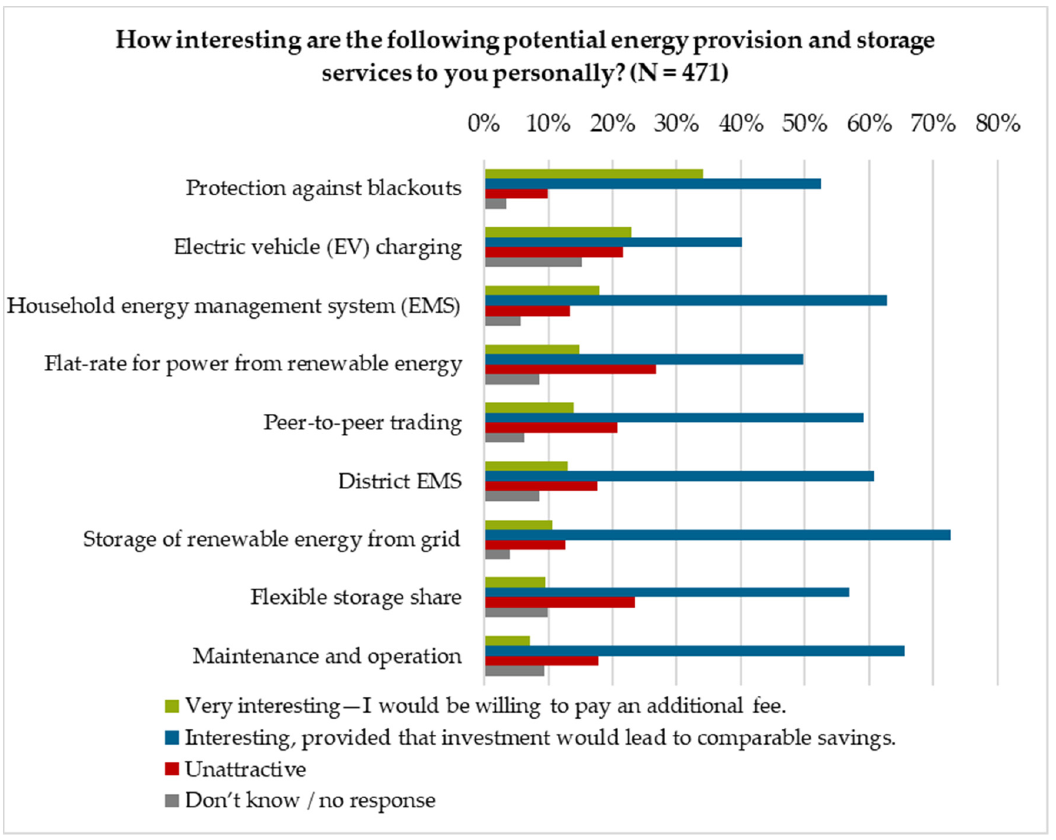
Figure 6. Assessment of various energy services.